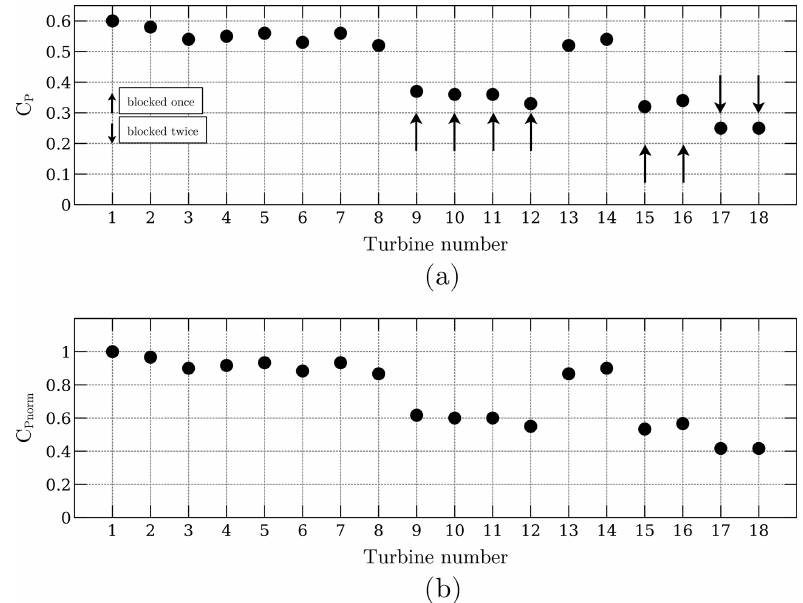
Figure 16. Wind farm array of 18 turbines using the 25m radius turbine from Shamsoddin and Porté-Agel (2016). Panel (a) shows the current C P , and panel (b) shows the normalized C P . Arrows pointing upwards denote turbines that are blocked by only one turbine, whereas arrows that point downwards denote turbines that have been blocked by two